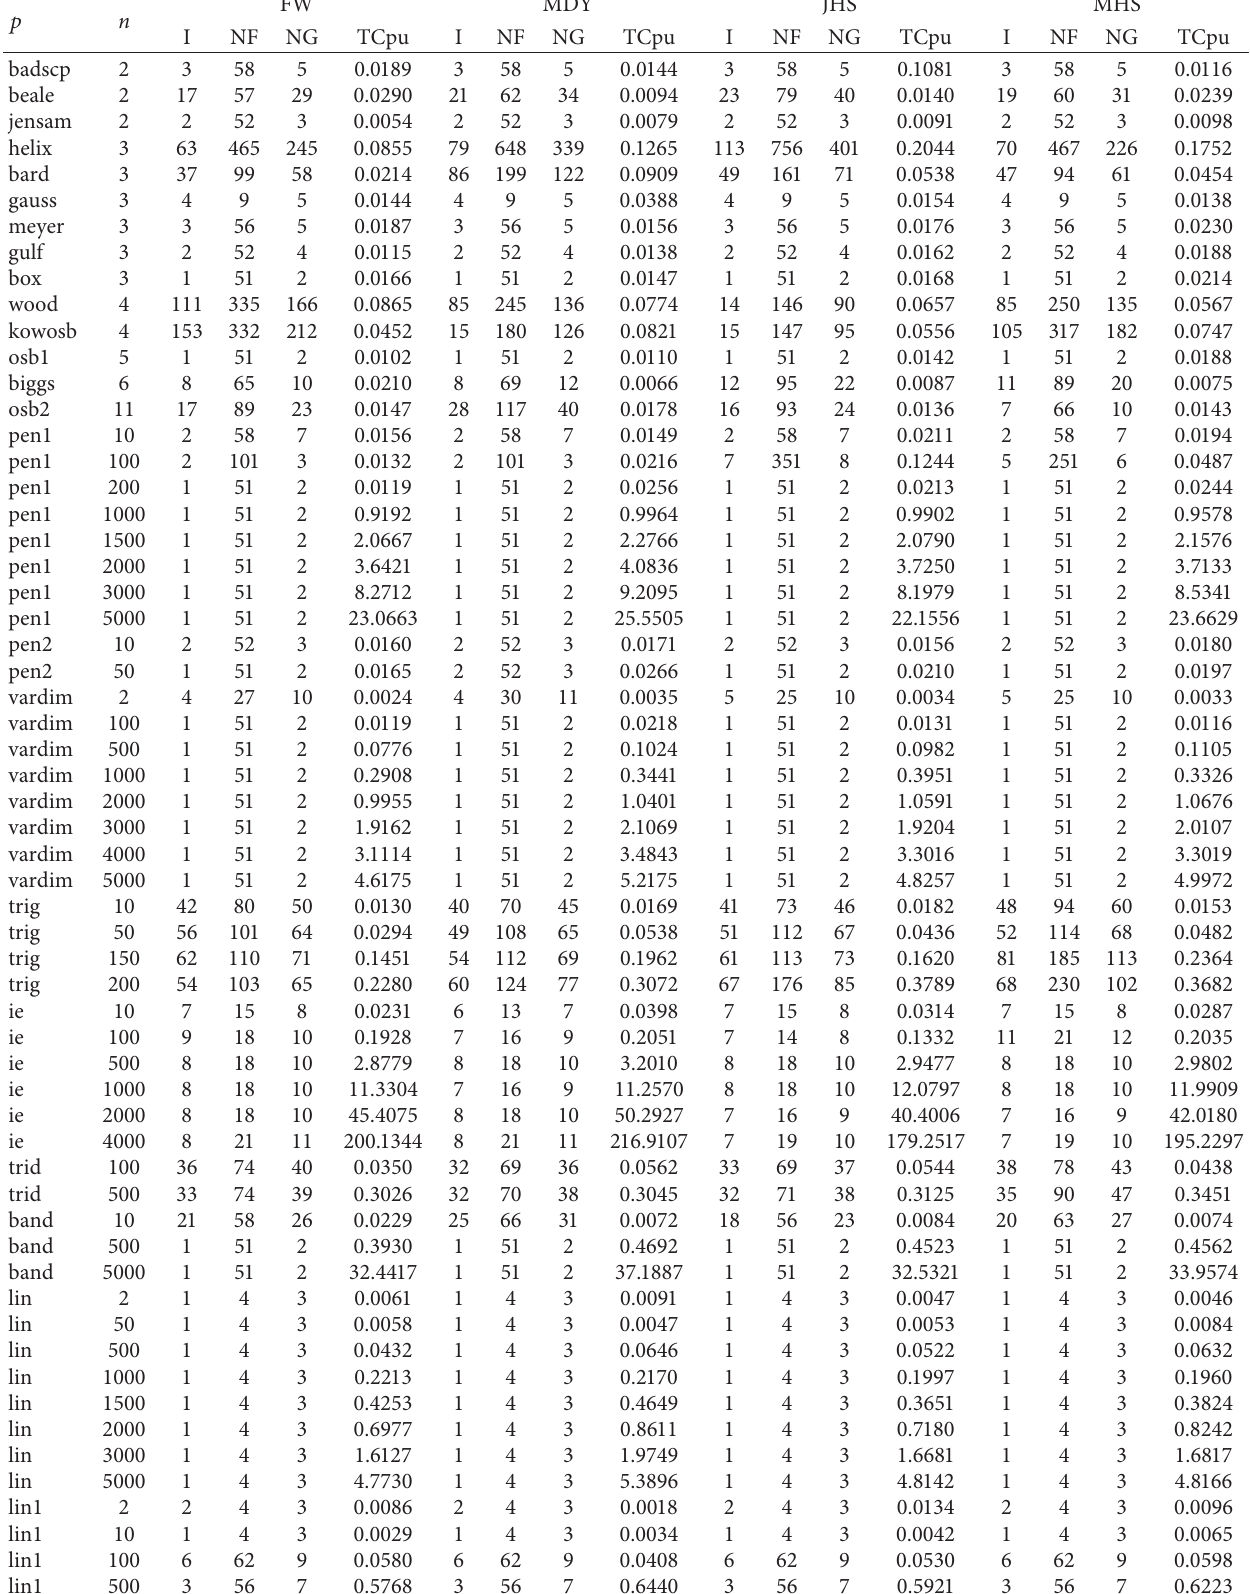
Table 1: Test results of the FW method, MDY method, JHS method, and MHS